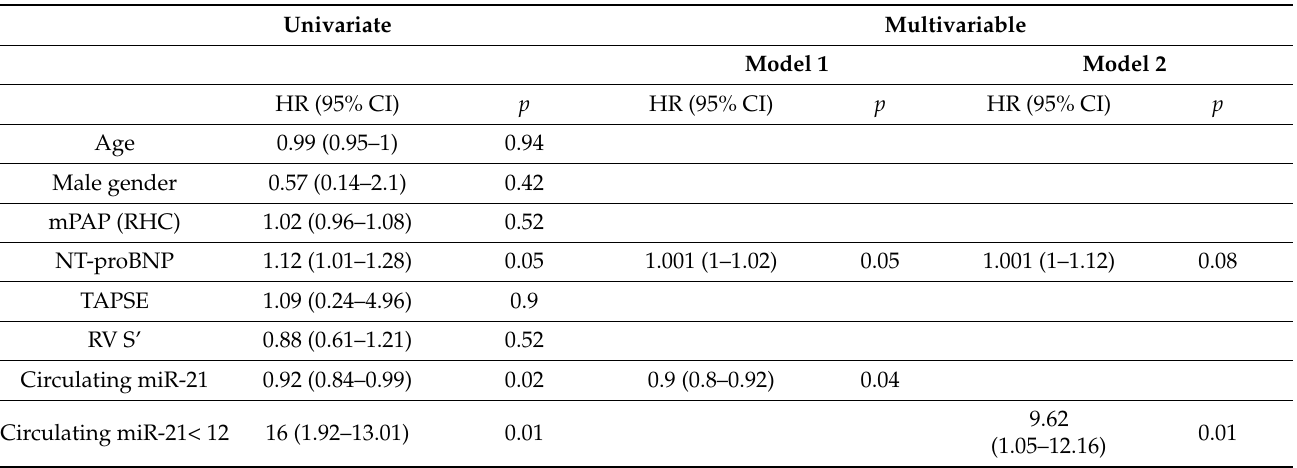
Abbreviation as Table 1. In Model 1, miR-21 as continuous variables; In Model 2, miR-21 < 12 ng/mL as categorical